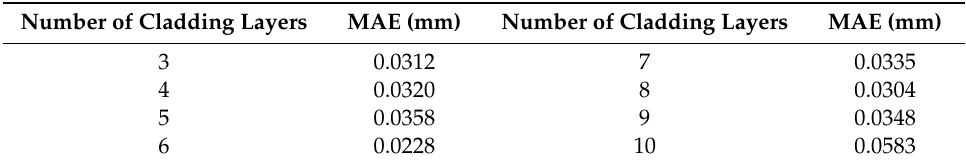
Table 7. Predicted precision of the established model.